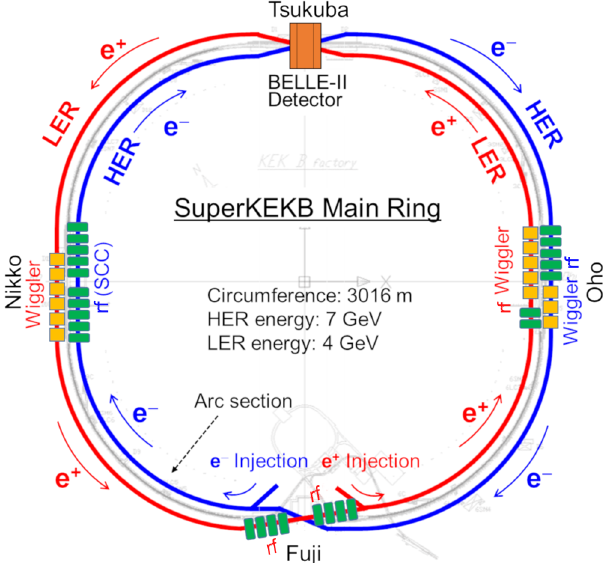
FIG. 2. Layout of the SuperKEKB Main Ring (MR). One ring consists of four arc sections, four straight sections, and one collision point at Tsukuba (Belle II).